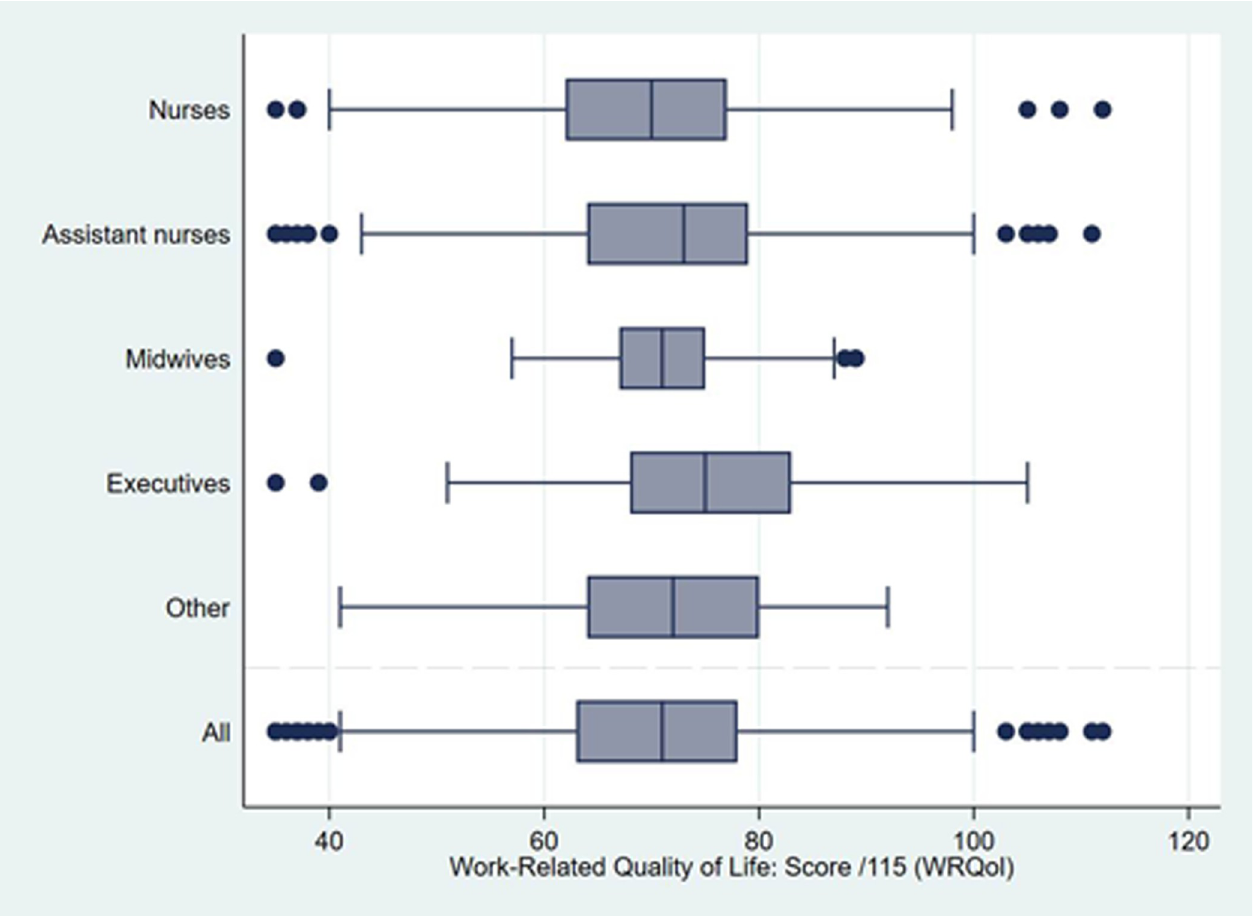
Fig 1. Boxplots of quality of working life scores among night-shift healthcare workers according to their professional category (n = 1,387, AP-HP ALADDIN survey, Paris public hospitals). The boxplots present median values and interquartile ranges (box) for the full-scale WRQoL score (range 0 to 115). Lines (whiskers) include all points within 1.5 interquartile range of the nearest quartile. Higher score values denote better